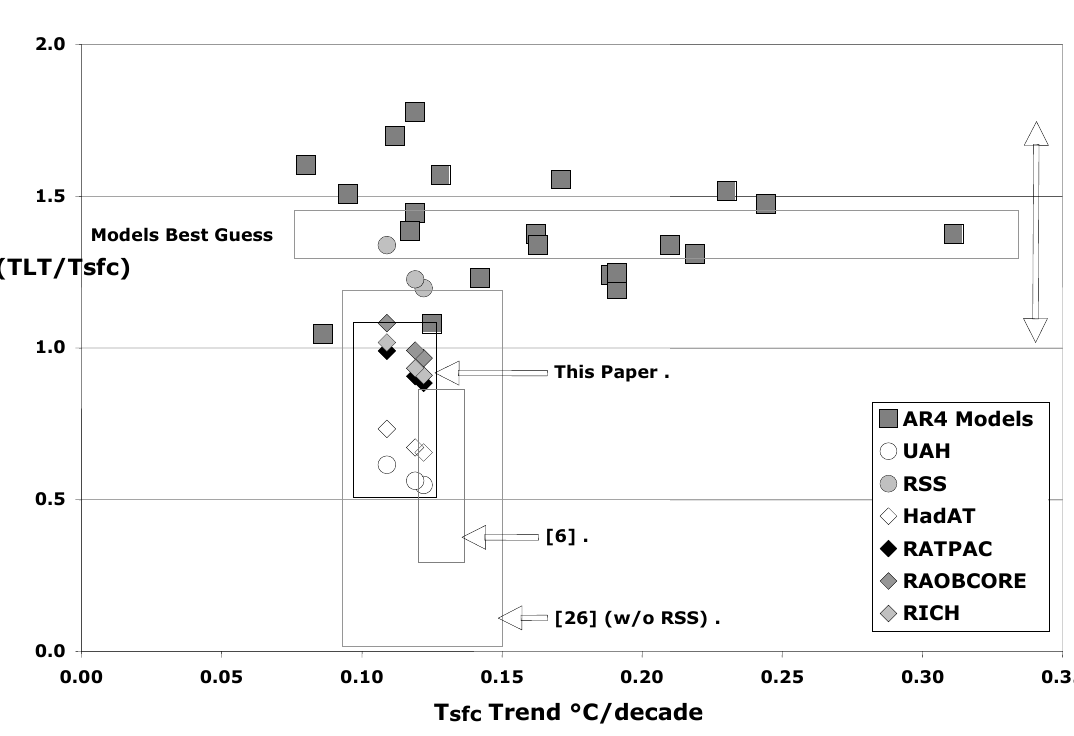
Figure 10. Relationship of T to T . Filled squares: the 21 model realizations for sfc LT 1979–1999. Circles (satellite) and Diamonds (balloon) observational results reported here (see Table 2). Boxes: extent of SRs calculated from observations in this study